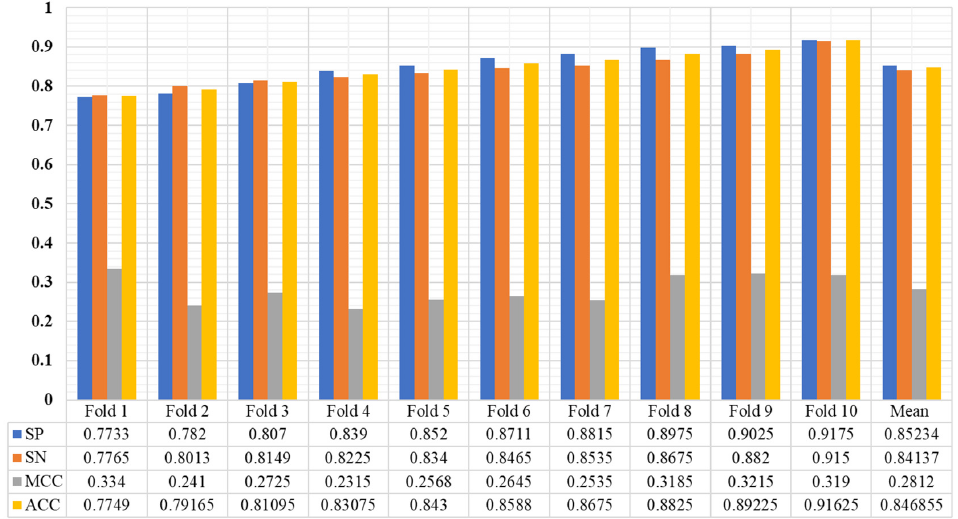
Figure 4. The performance of the proposed model using benchmark enhancers sequence dataset (Stage 2). (Stage